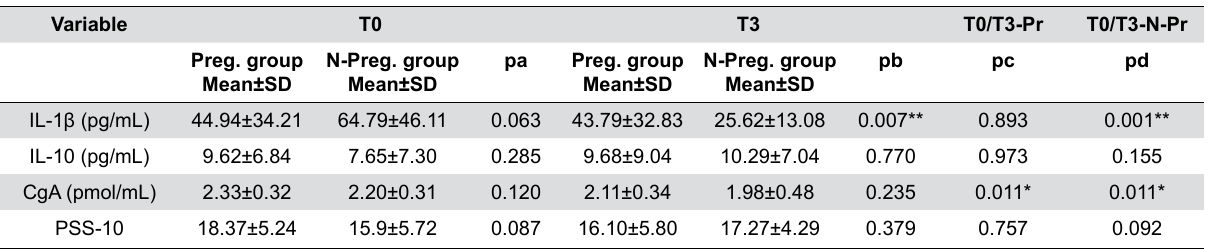
Table 3- Gingival crevicular fluid (GCF) cytokines levels and stress markers in patients within the groups at baseline (T0), at the end of treatment (T3), and between T0 and